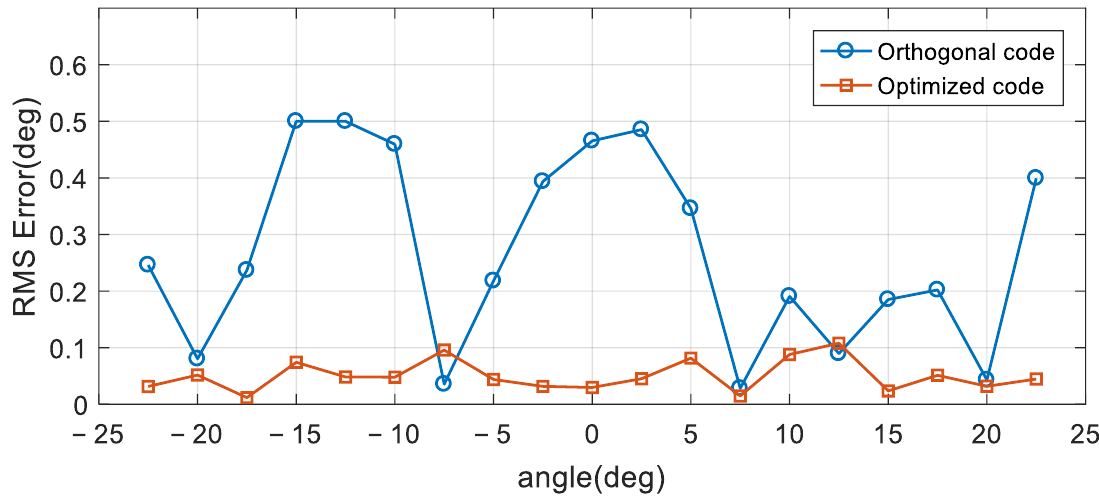
Figure 11. RMS error according to the target direction at Δ𝑓 = 0.5 for high SNR.